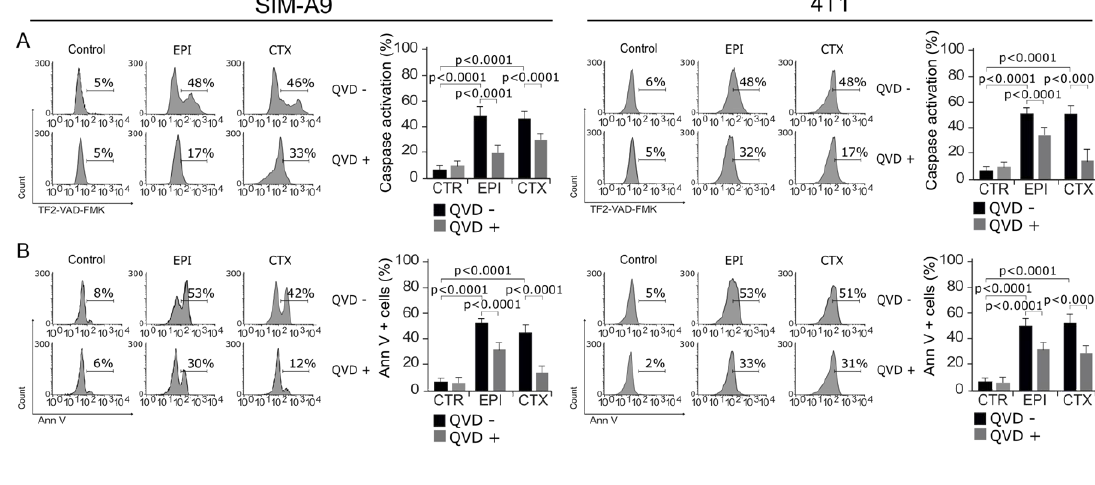
Figure 5: Activation and role of caspases in cell death. A ) Representative histograms of caspase activation measured by flow cytometry using TF2-VAD-FMK in SIM-A9 and 4T1 cells treated with EPI and CTX for 24 hours (left). Bars at right represent the mean  SD. B ) Cells were pretreated with the pan-caspase inhibitor QVD-Oph and then treated with EPI or CTX (CC 50 ) for 24 hours and Ann V positive SIM-A9 or 4T1 cells were assessed. Representative histograms (left) and bar graphs presenting mean  SD (right) are shown.